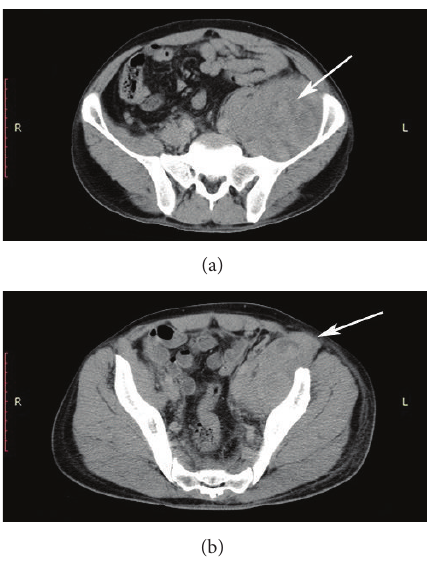
Figure 1: Abdominal CT showed a large retroperitoneal hematoma, which extends through femoral triangle. White arrows in the pic- tures highlight left iliopsoas hematoma and its inguinal extension.